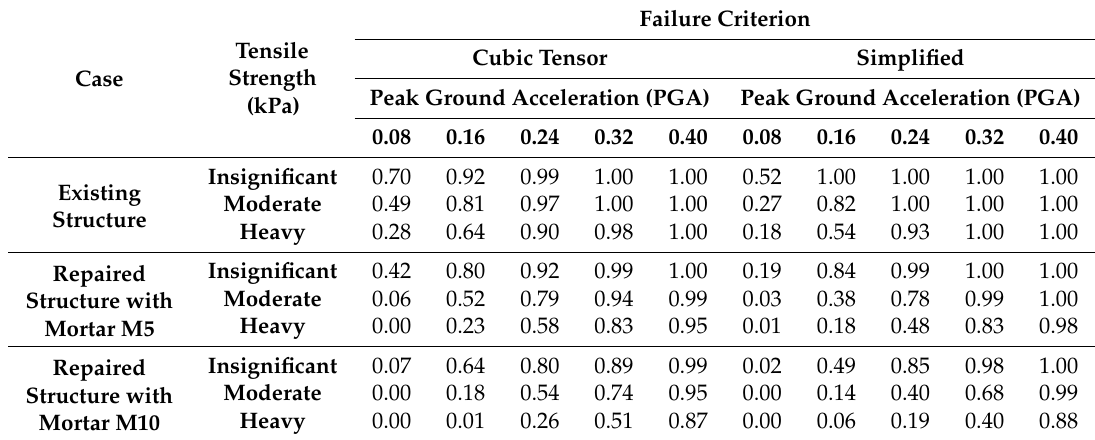
Table 10. Probability of exceeding a damage state for the structure before and after interventions (normal